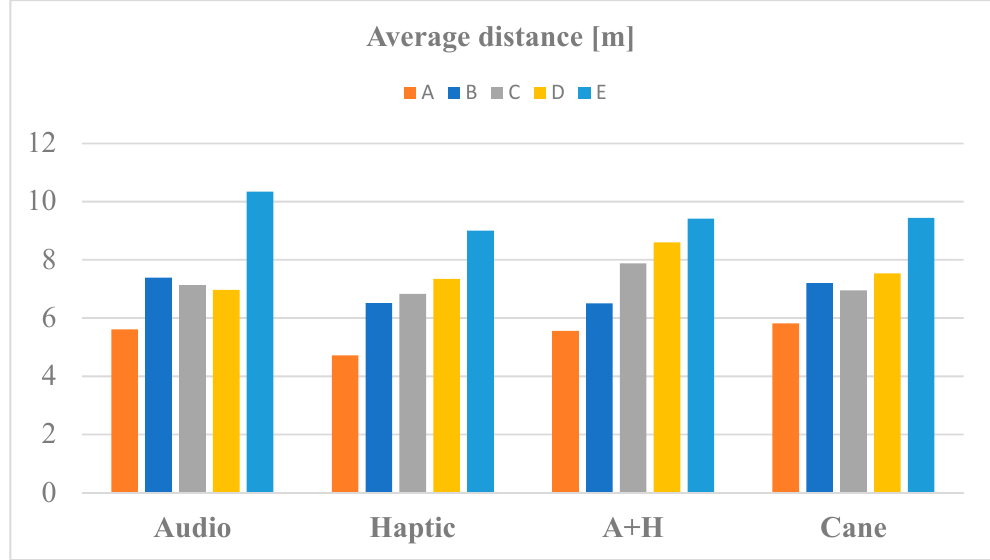
Figure 14. The average distances of navigation tasks.